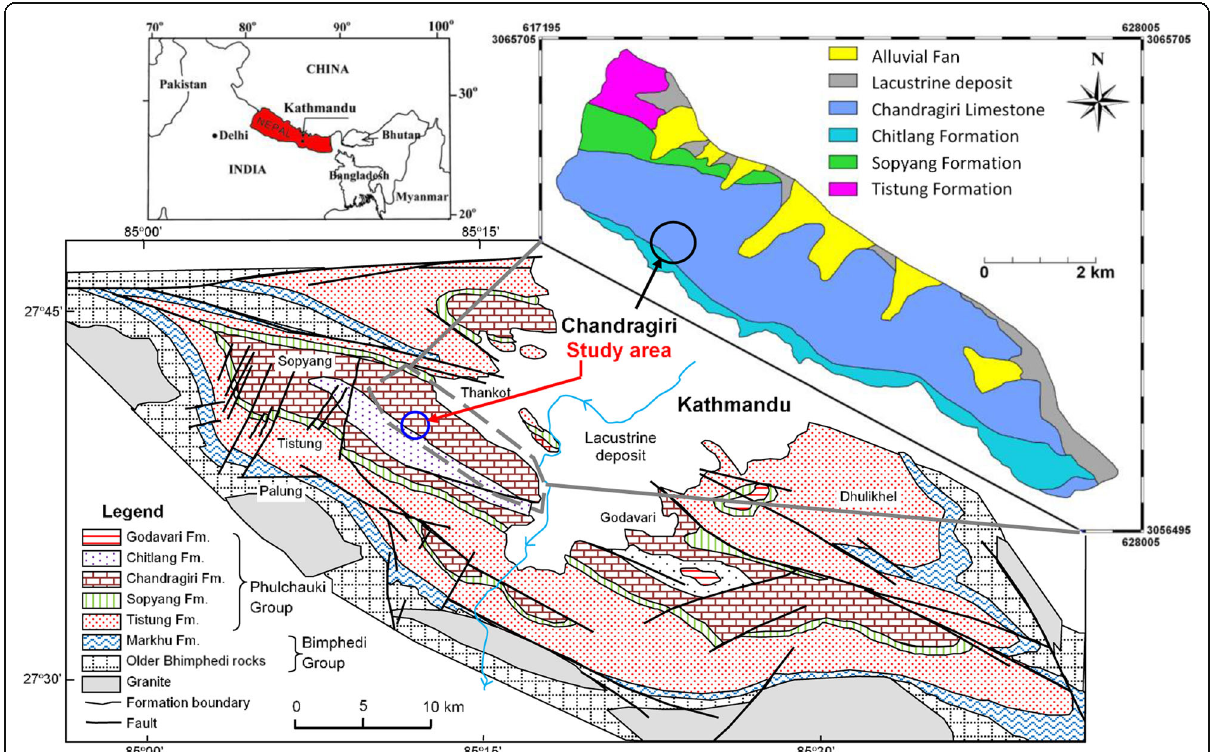
Fig. 2 Study area on regional geological map of Kathmandu basin (modified after Stöcklin and Bhattarai 1977 and Dahal et al.